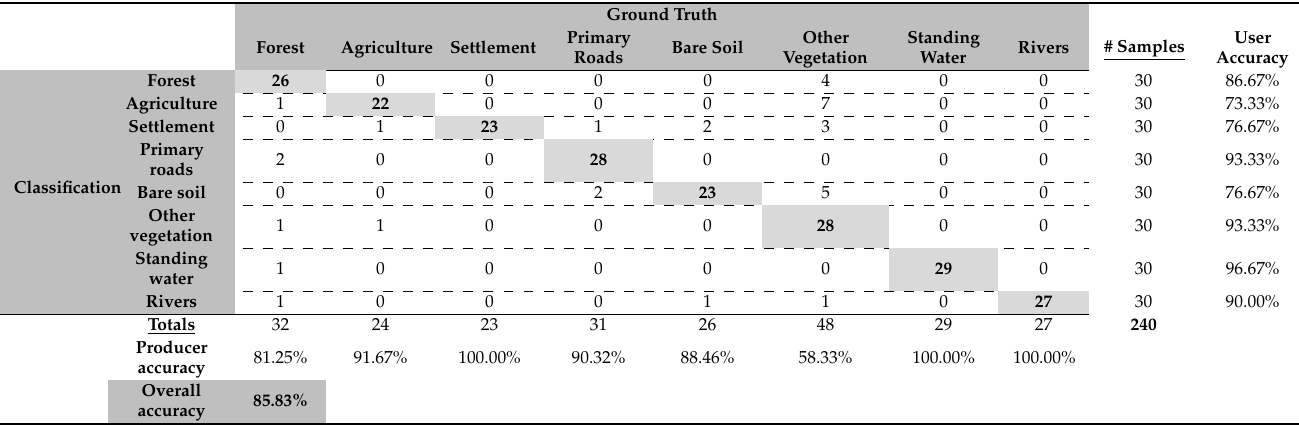
Table 5. Validation Matrix for Service 1: LULC classification for epoch 1991.